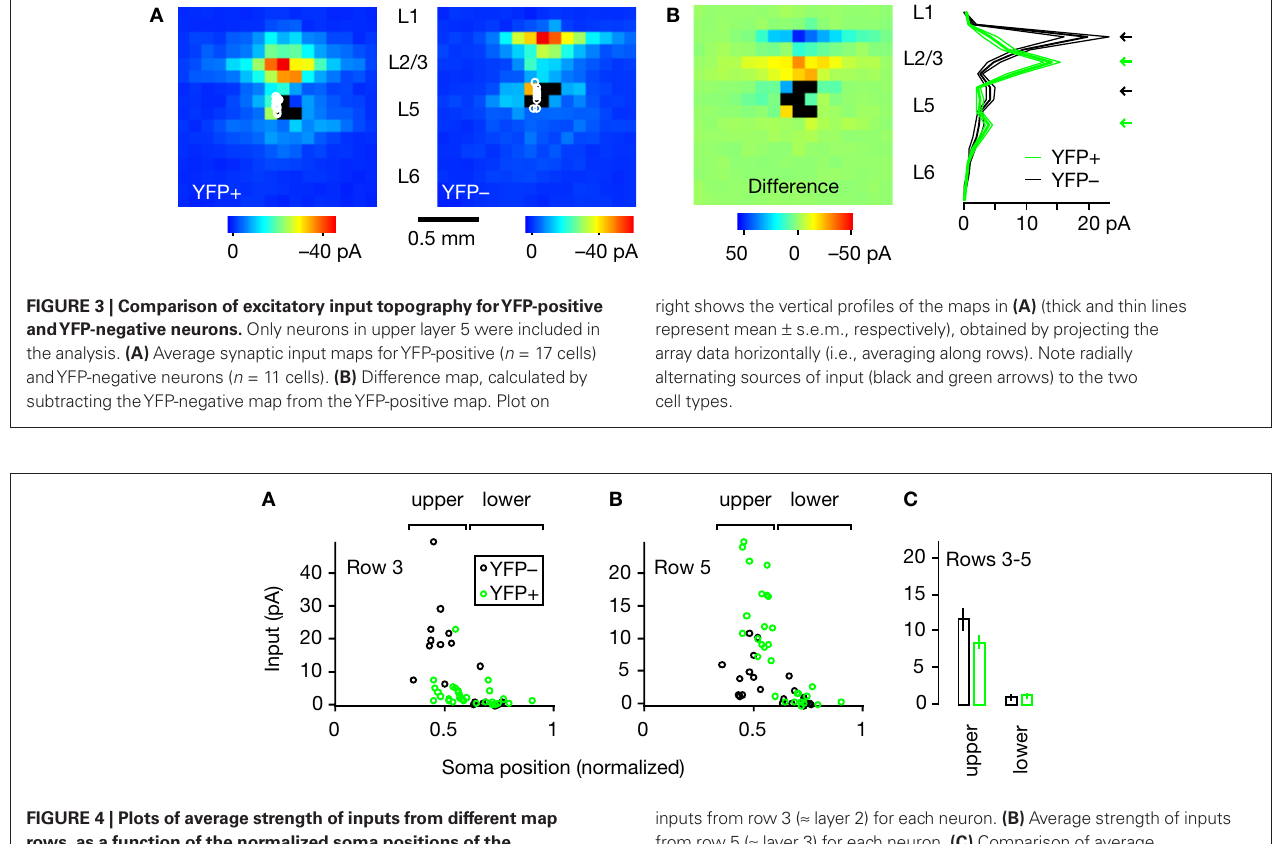
inputs from row 3 ( ≈ layer 2) for each neuron. (B) Average strength of inputs from row 5 ( ≈ layer 3) for each neuron. (C) Comparison of average strength of inputs from rows 3–5 ( ≈ layer 2/3) for upper- versus lower-blade neurons.